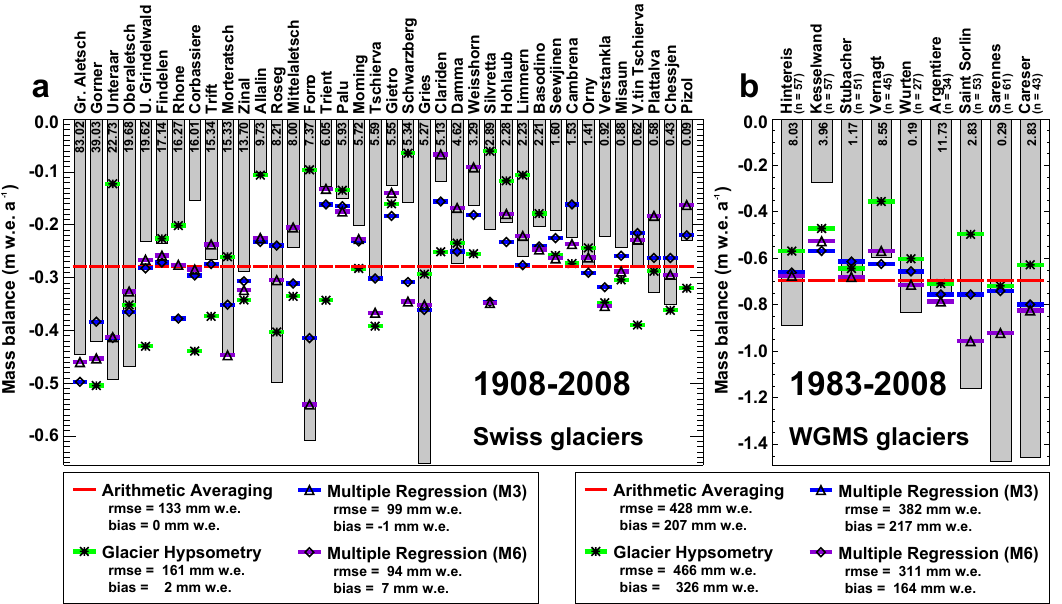
Fig. 3. Comparison of different methods for extrapolating glacier surface mass balance. (a) 100-yr mean mass balance (1908–2008) of 38 Swiss glaciers (Huss et al., 2010a,b) is shown with bars. Glacier area (by 2003) in km 2 is stated inside the bars. Mass balance extrapolated to these glaciers using arithmetic averaging (red lines), glacier hypsometry (asterisks), and multiple regression (triangles, diamonds) is shown. The rms error and the mean bias are given for each method. (b) Same as in (a) but for the 25-yr mean mass balance (1983–2008) of 9 glaciers provided by WGMS (2008). The total length of the series ( n ) and glacier area is given.